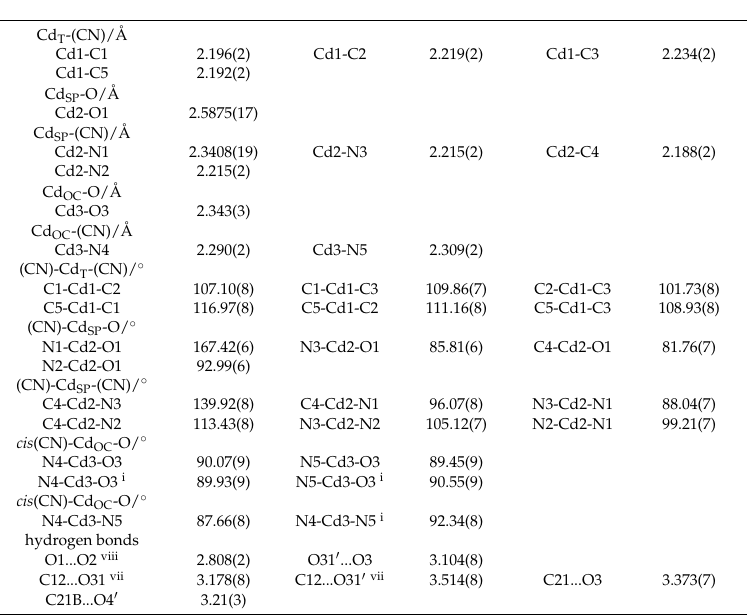
Table 3. The selected bond lengths and angles in II